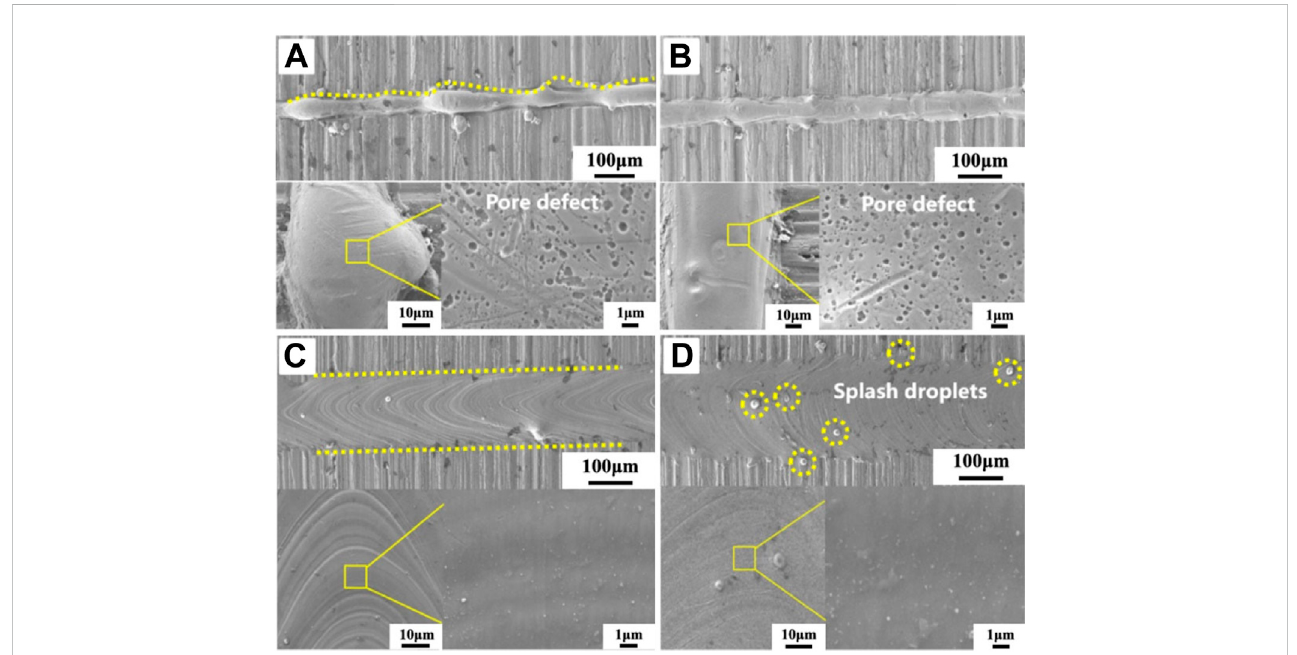
FIGURE 2 Single molten track SEM morphology under LEDs of (A) < 100 J/mm 3 , (B) 100 J/mm 3 ~ 200 J/mm 3 , (C) 200 J/mm 3 ~ 500 J/mm 3 and (D) 500 J/mm 3 ~1019 J/mm 3 with enlarged surface morphology.